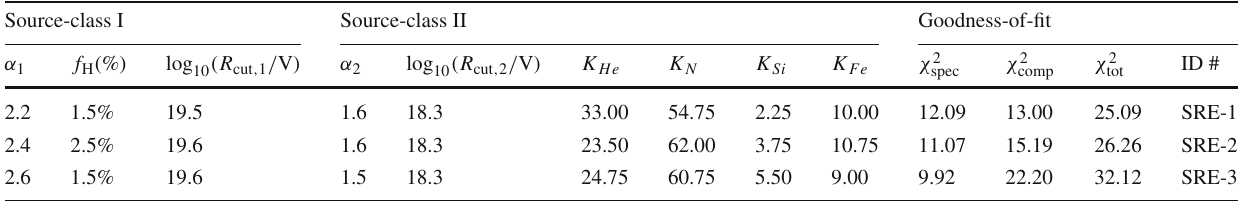
Table 4 Best-fits to UHECR spectrum and composition for two-population model ( m 1 = + 3, m 2 = −